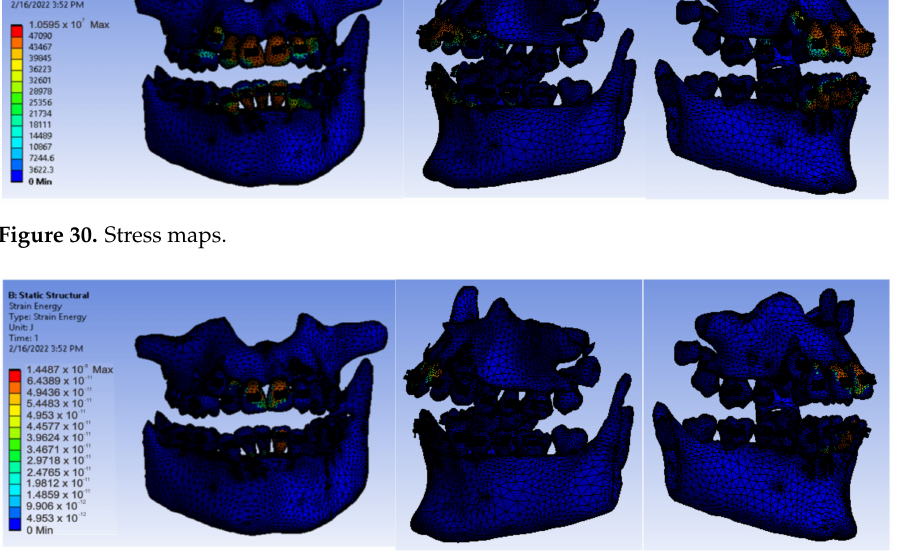
Figure 31. Deformation energy